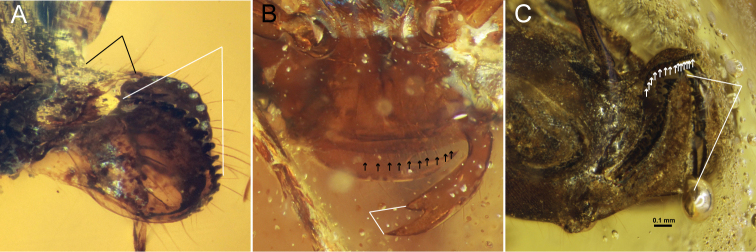
Mandibles of representative FormicoideaA †Camelosphecia
fossor gen. et sp. nov. holotype female, lateral oblique (ANTWEB1038930) B †Gerontoformica species, male, dorsal or full-face view (ANTWEB1032638) C †Chonidris
insolita holotype female, anterolateral oblique (FANTWEB00022, AntWeb: Vincent Perrichot).